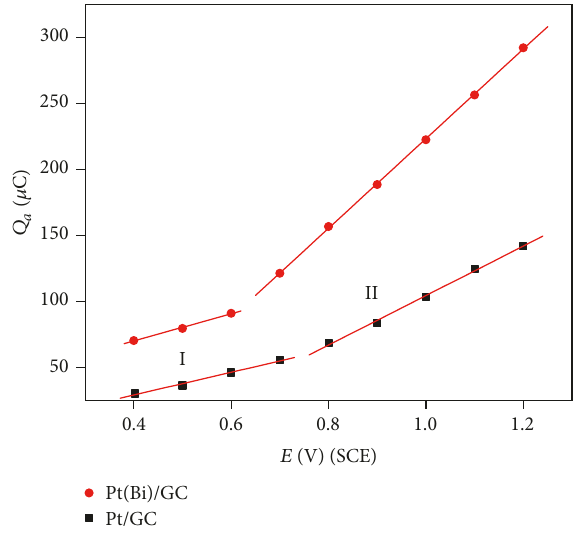
Figure 2: Oxide formation charge as a function of the forward potential scan limit (data obtained from Figure